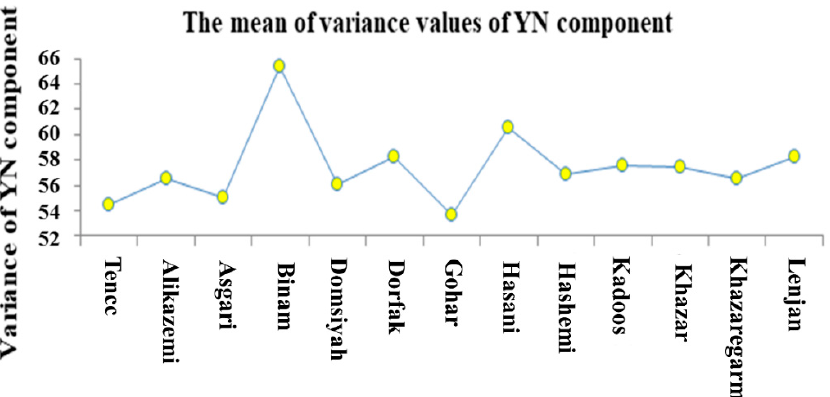
Figure 6. The mean standard deviation of the blue component for 13 paddy cultivars.